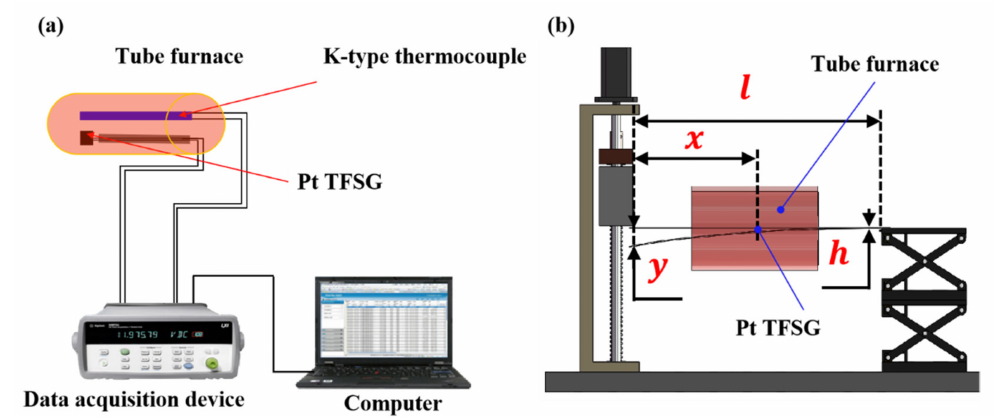
Figure 2. Experiment setups for ( a ) temperature-resistance detection and ( b ) micro-strain